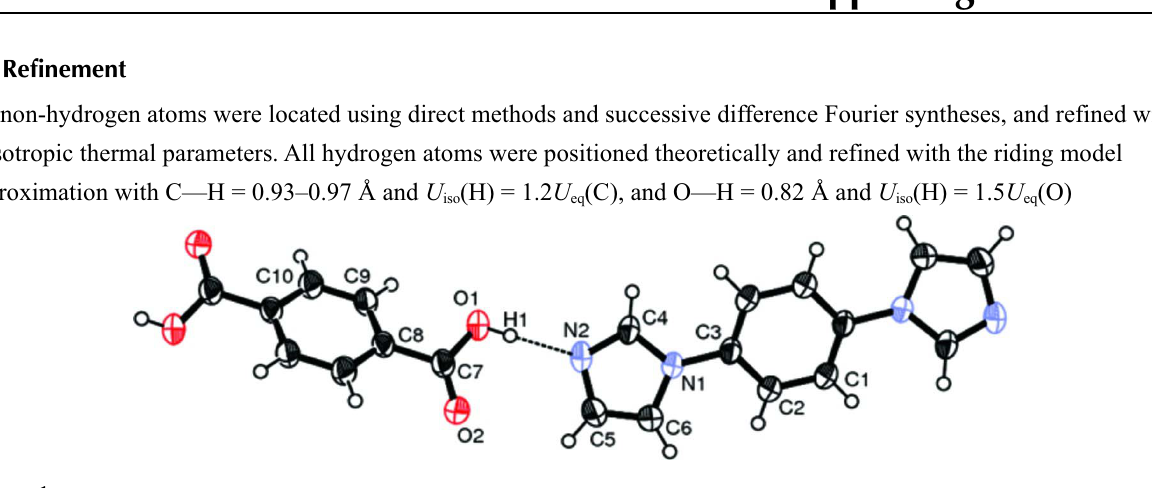
Figure 1 The molecular structure of the title compound, showing 50% probability displacement ellipisoids; hydrogen bonds are illustrated by dashed lines.